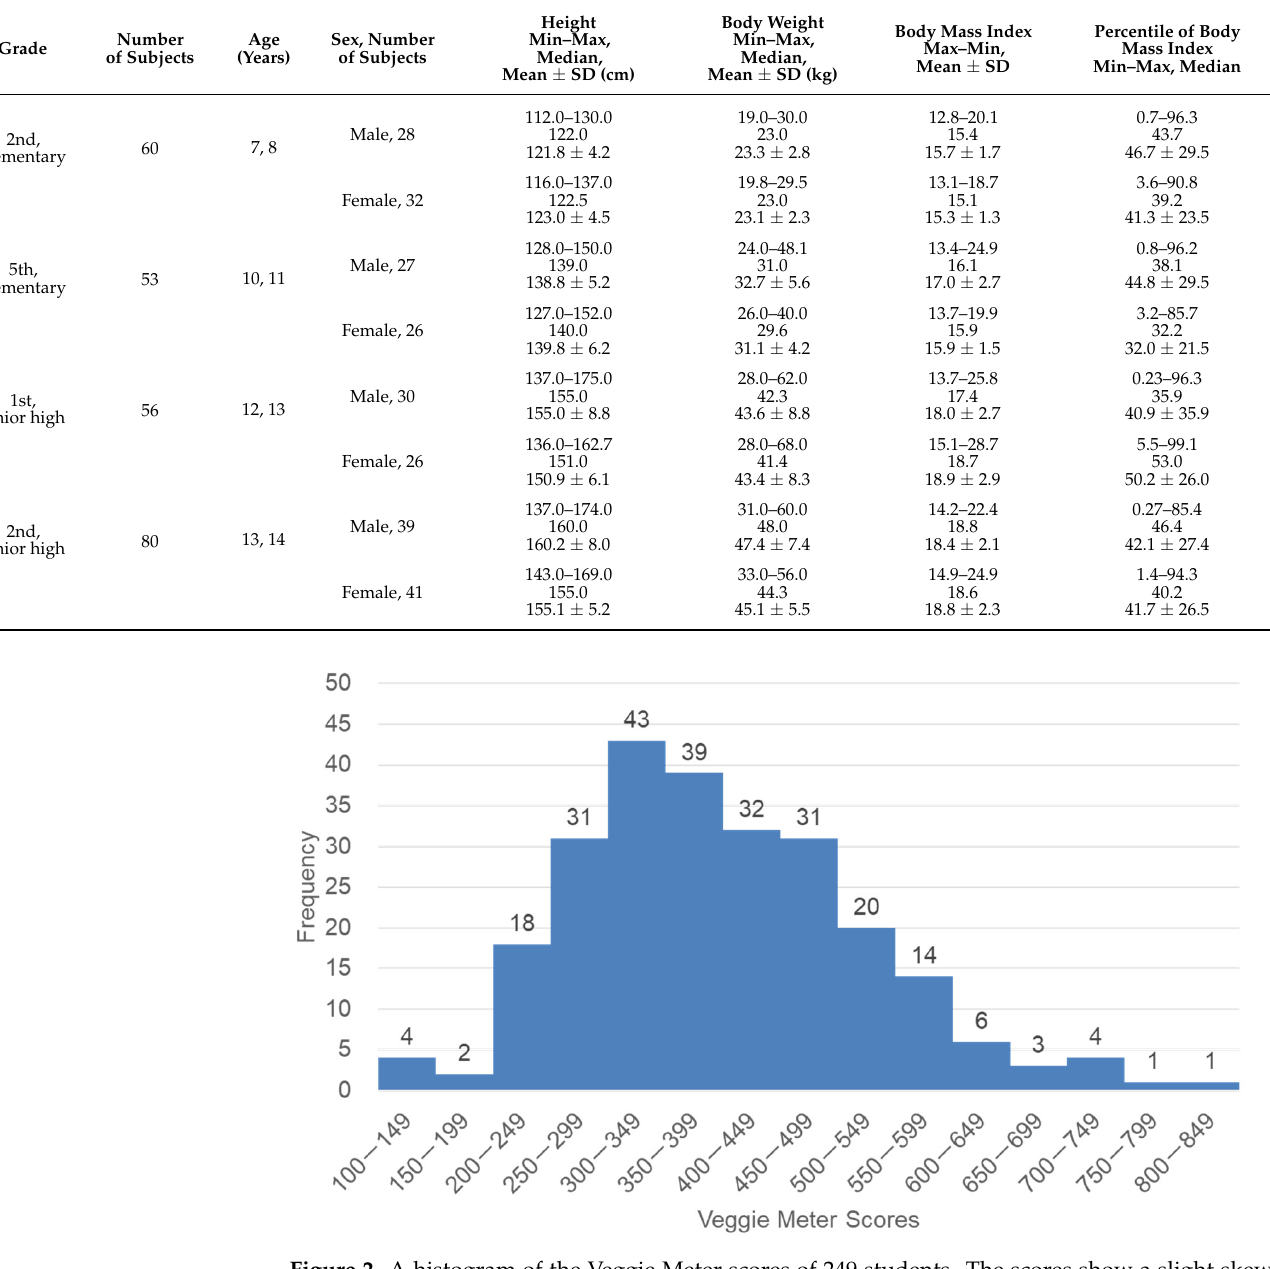
Table 3. Baseline characteristics of the included subjects.